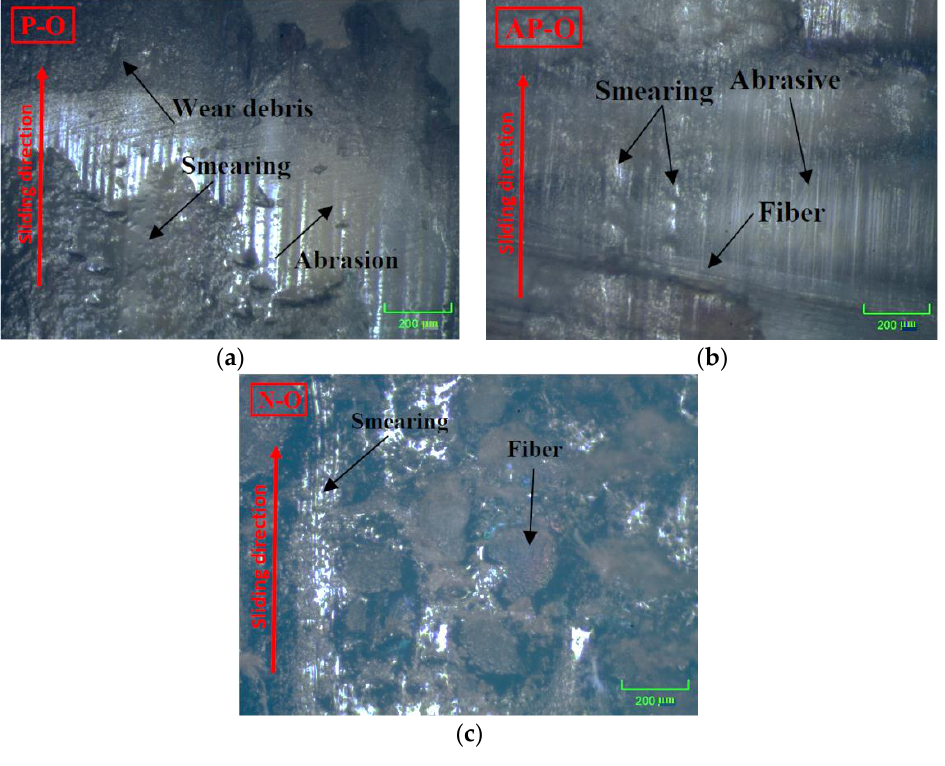
Figure 9. Wear tracks of tested samples. ( a ) Parallel orientation, ( b ) anti-parallel orientation and ( c ) normal orientation, obtained by optical microscopy.